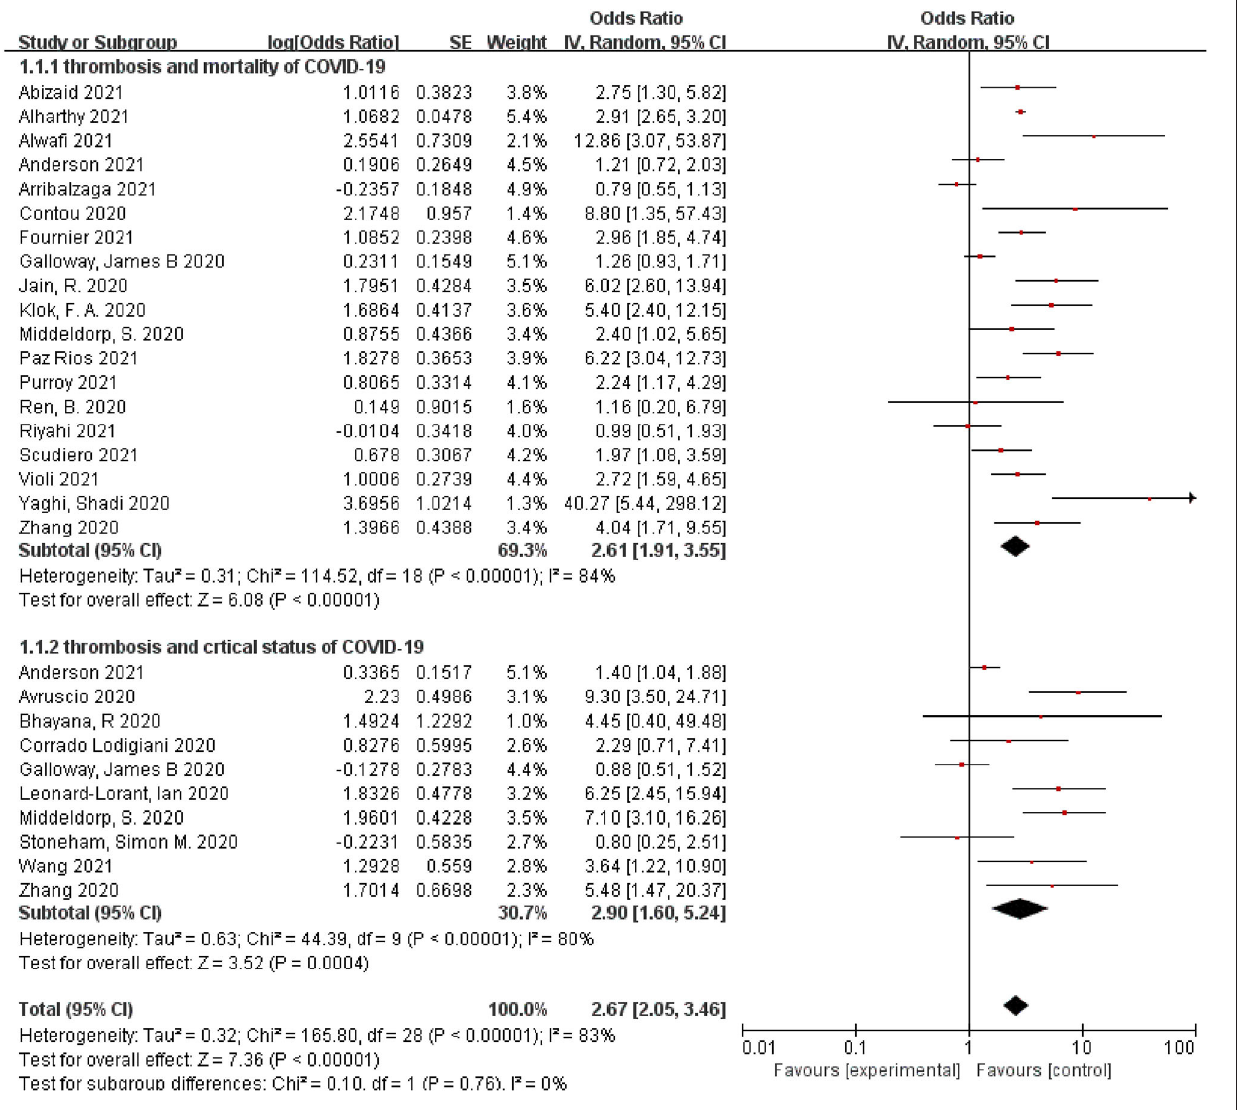
status. The same stratified analyses were conducted ( Table 2